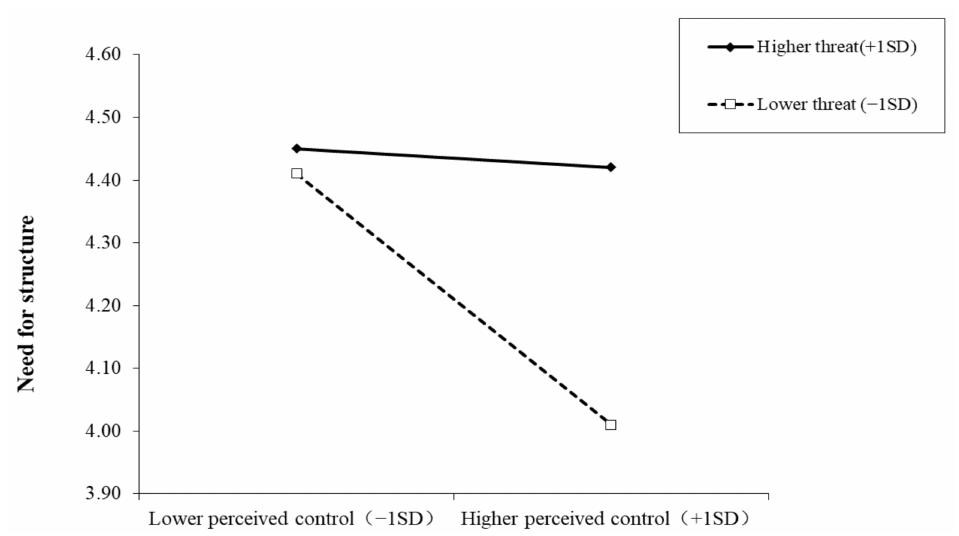
Figure 7. Interactive effect of pandemic threat and perceived control on need for structure. Note: Pandemic threat is graphed for two levels: higher pandemic threat (1 SD above the mean) and lower pandemic threat (1 SD below the